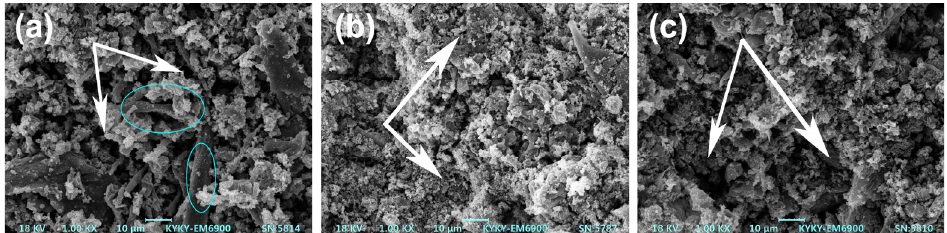
Figure 4. SEM images of charred residue of PP/SF composites after cone calorimeter test. ( a ) (PP/IFR)/SF; ( b ) (PP/SF)/IFR; ( c ) PP/IFR/SF. In contrast, the charred layer of PP/IFR/SF and (PP/SF)/IFR composites was relatively thick and dense. In particular, the charred layer formed by (PP/SF) /IFR was thick and continuous, which could effectively play the role of heat and oxygen isolation, so as to endow the composite with excellent flame-retardant